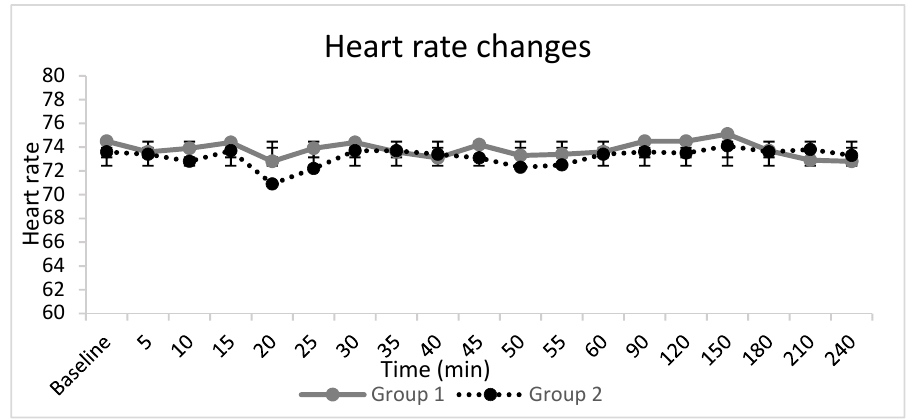
Figure 5. Heart reate changes. The line graphs represent the mean and standard deviation in group 1 and 2.